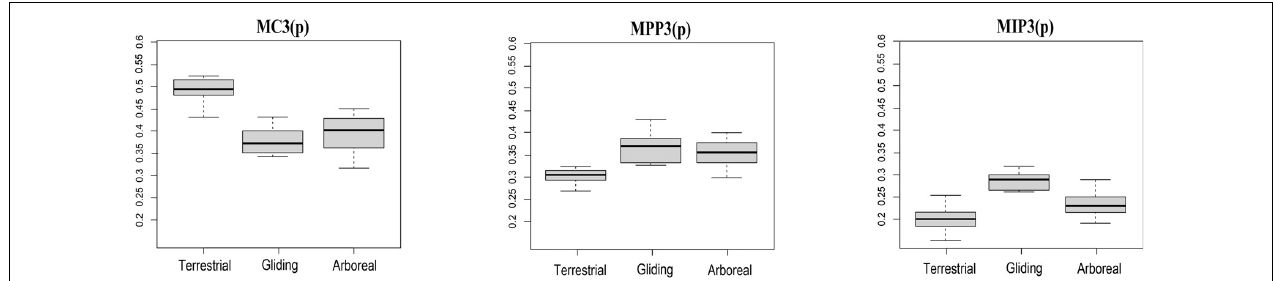
FIGURE 3 | The distribution of the three indices among each locomotory mode. The abscissa represents the locomotory modes and the ordinate represents the ratios of the indices. MC3(p): The proportion of MC3 in the total combined length of the three elements; MPP3(p): The proportion of MPP3 in the total combined length of the three elements; MIP3(p): The proportion of MIP3 in the total combined length of the three elements. Terrestrial mode includes ST and RT groups; Arboreal mode includes SA, RA, and PA groups; Gliding mode includes DG and RG groups. Wilcoxon tests of the three indices among each locomotry mode all show significant P -values ( P <